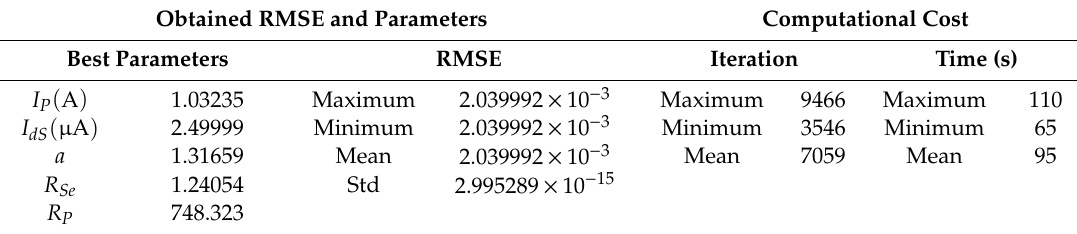
Table 7. Results for the single-diode module.